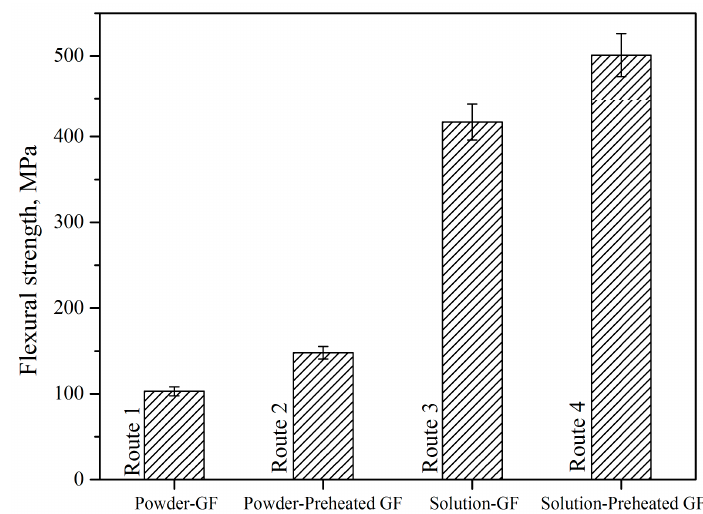
Figure 3. Flexural strength of different types of PES composites (50/50%, 350 °C preheating temperature).